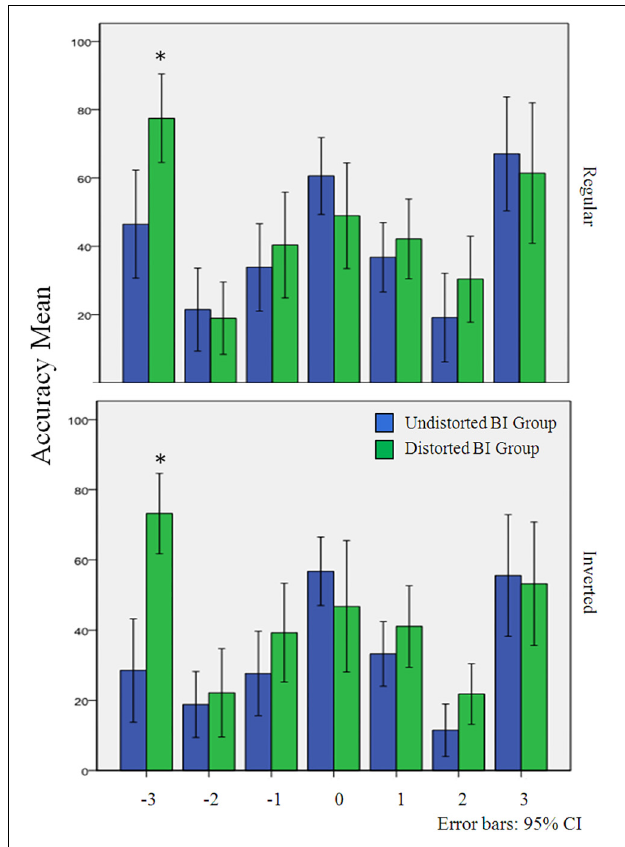
FIGURE 3 | Accuracy averages of BI perceptual groups divided by silhouette figure and experimental condition in Experiment 2. Confidence interval of 95%. ∗ p <